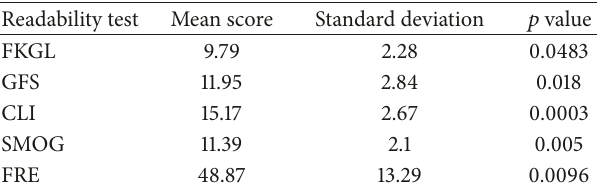
Table 4: Mean readability scores of health information websites.